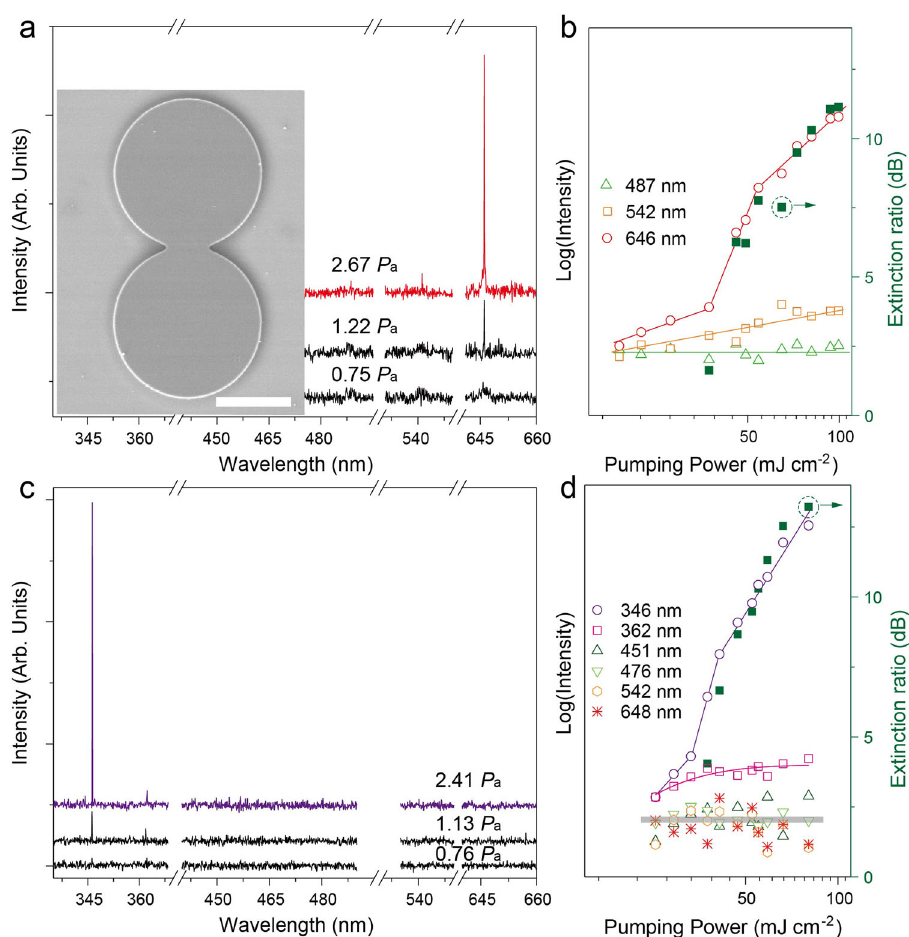
Fig. 3 Realization of single-mode lasing in UCNCs-based size-mismatched PMs device. The emission spectra of PMs structure are under ( a ) 808 nm, and ( c ) 980 nm right pumping, respectively. The inset gives the SEM image of a single PMs structure with a scale bar of 50 μ m. The exact diameters of the top and down microdisks are 97.84 and 99.30 μ m, respectively. b , d Characteristic light-light curves of the typical peaks in ( a , c ), respectively. The green fi lled boxes represent the E-ratio, and solid lines are linear fi ttings to guide the